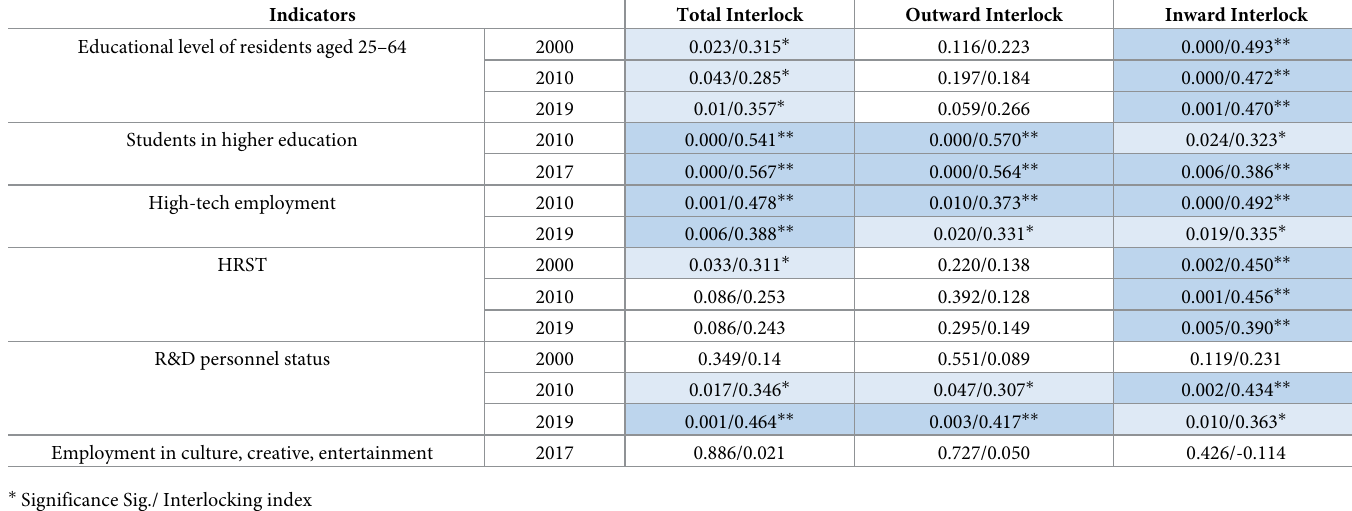
Table 6. The relationship between talent indicators and three interlock